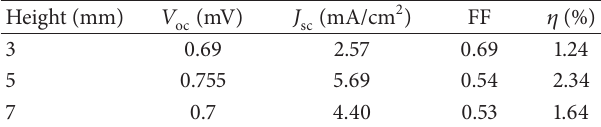
Figure 11: Photovoltaic curves ( J-V ) of the prepared flat DSSC made by different counter electrodes. Table 3: Photovoltaic parameters of the 3D DSSC made by a Pt counter electrode at different cell heights.